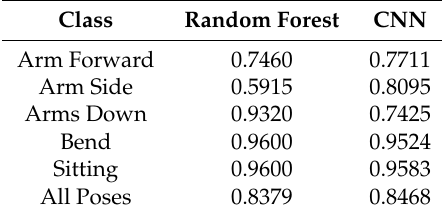
Table 17. Comparison between the F1-scores attained by the random forest and CNN models during the two corner TIS test.